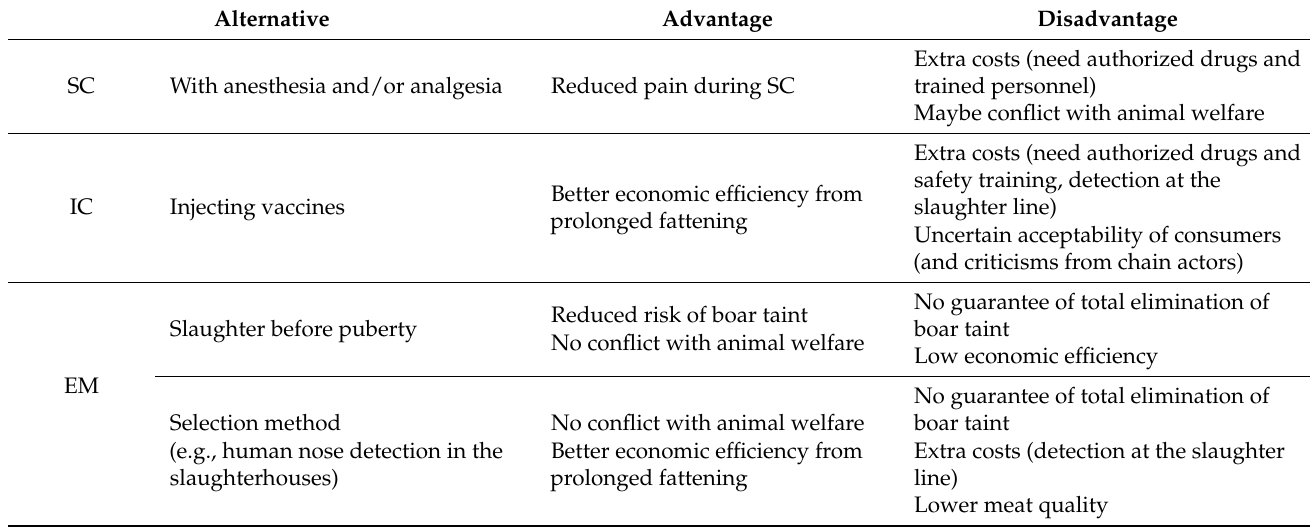
Table 1. Analysis of the pros and cons of available alternatives as compared with the standard surgical castration without any pain